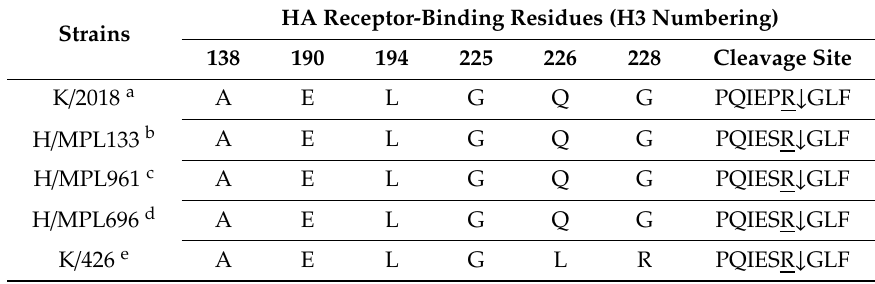
Table 3. Comparison of amino acid sequence in HA receptor-binding sites of human and avian H2 influenza virus